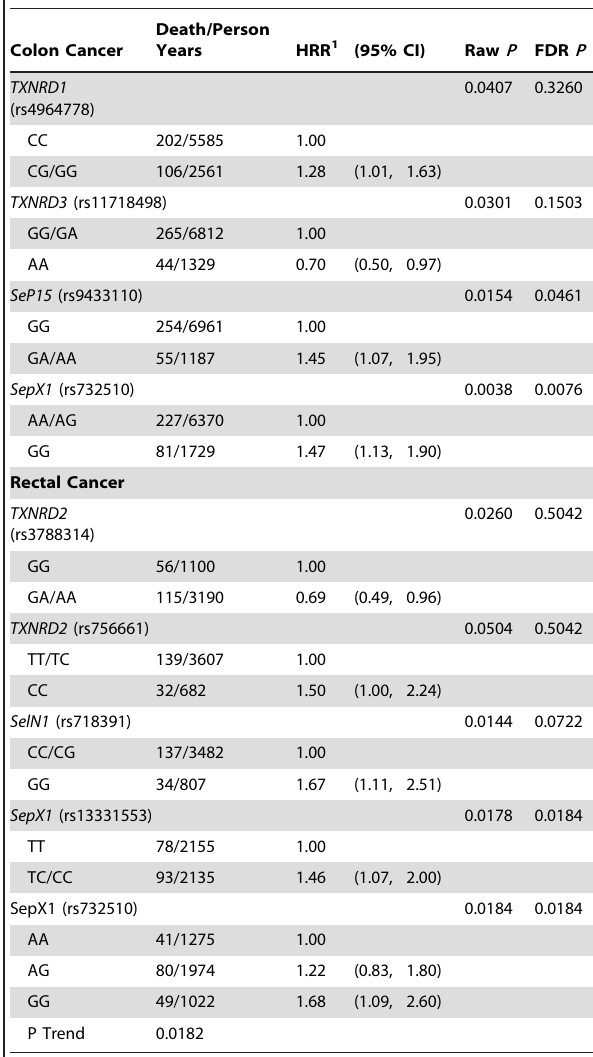
Table 6. Association between TNXRD and Selenoprotein genes and survival after diagnosis with colon and rectal